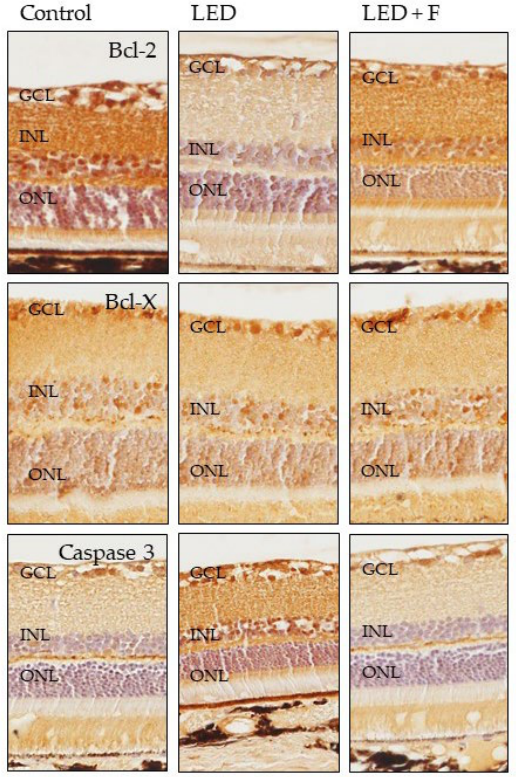
Figure 7. Immunohistochemical detection of Bcl-2 ( upper panel ), Bcl-X ( central panel ) and Caspase- 3 ( lower panel ) in the three groups of rats investigated. LED: animals exposed to LED-backlit screen for 3 months; LED + F: animals exposed to filtered LED-backlit screen for 3 months. GCL: ganglionic cells layer; INL: inner nuclear layer; ONL: outer nuclear layer.